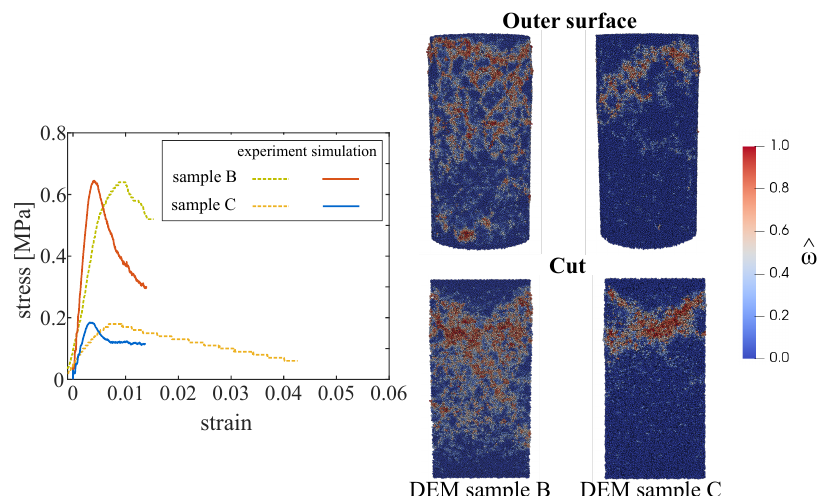
Figure 9. ( Left ): Uniaxial compression of samples B and C: comparison of experimental measurements and numerical results. ( Right ): Distribution of the damage parameter ˆ ω obtained from the DEM simulation at strain level 0.008 for sample B (void volume fraction = 42%) and sample C